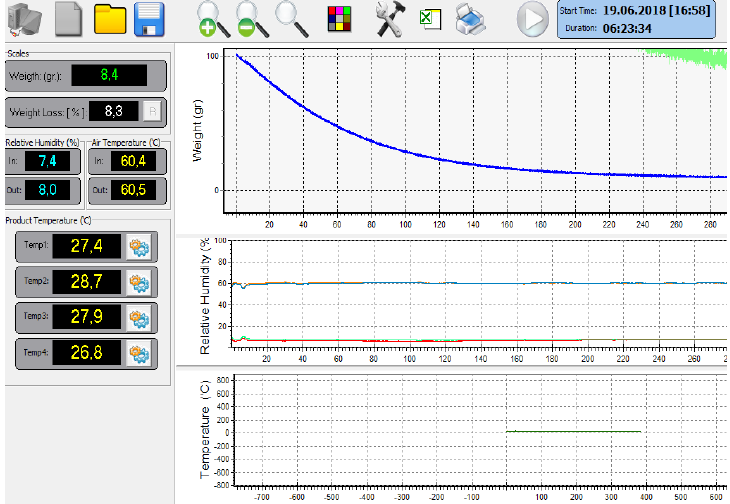
Figure 2. Data electronic processing. 1 – dial (indicates product’s mass dropping curve), 2 – dial (indicates drying chamber input and output drying agent temperature) 3 – dial (indicates drying chamber input and output drying agent